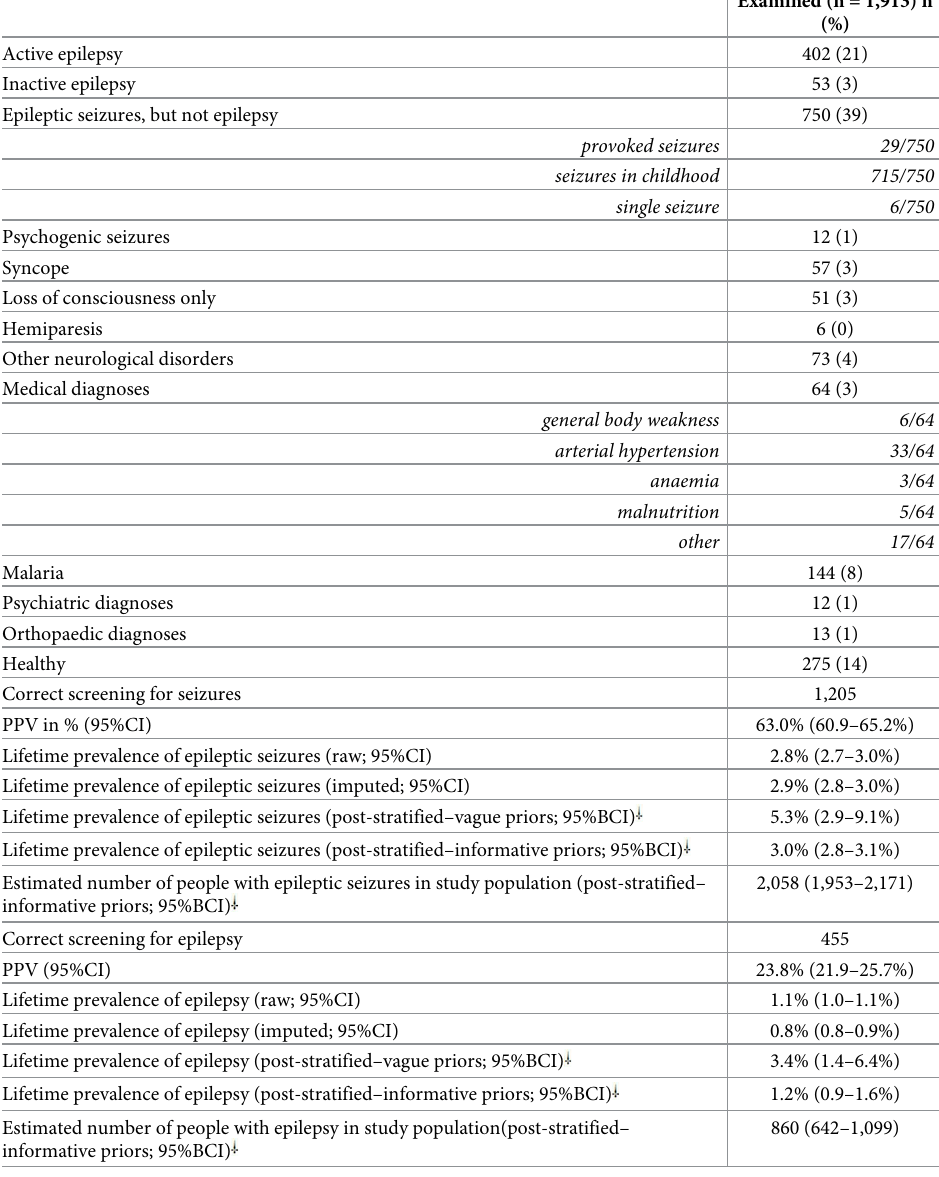
Table 2. Diagnoses of people screening positive in a questionnaire on epileptic seizures in a rural population in Balaka district, Malawi, October to December 2012.